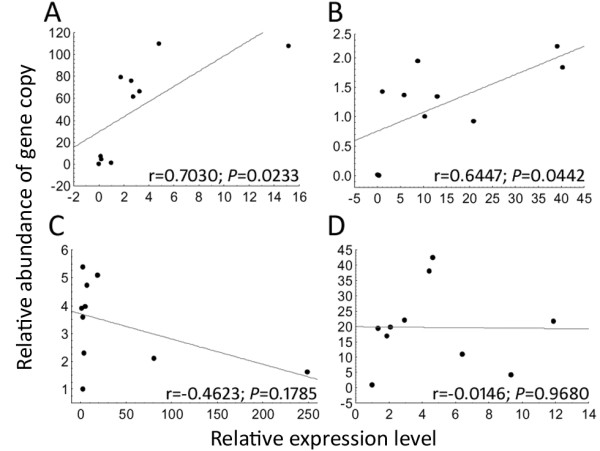
Examples of correlations between relative abundance of gene copy and basal gene expression levels for four gene markers. Relative expression and gene copy abundance were estimated by qPCR at individual level (n = 10) for (A) wy0aba11yc21fm1.1.a.cg.2, (B) cdn20p0004b10.f.1.a.cg.2, (C) Multiple EGF-like domains 10, and (D) wy0aba18yb03fm1.1.a.cg.2. Relative expression levels were obtained according to the 2−ΔΔCq method using the Cg-rpl40 as constitutively expressed gene. Relative abundances of gene copy were obtained with the same method but using the single copy Cg-bpi gene as reference. Grey line represents linear fit, significant correlations are indicate by P < 0.05 and r indicates the correlation coefficient.